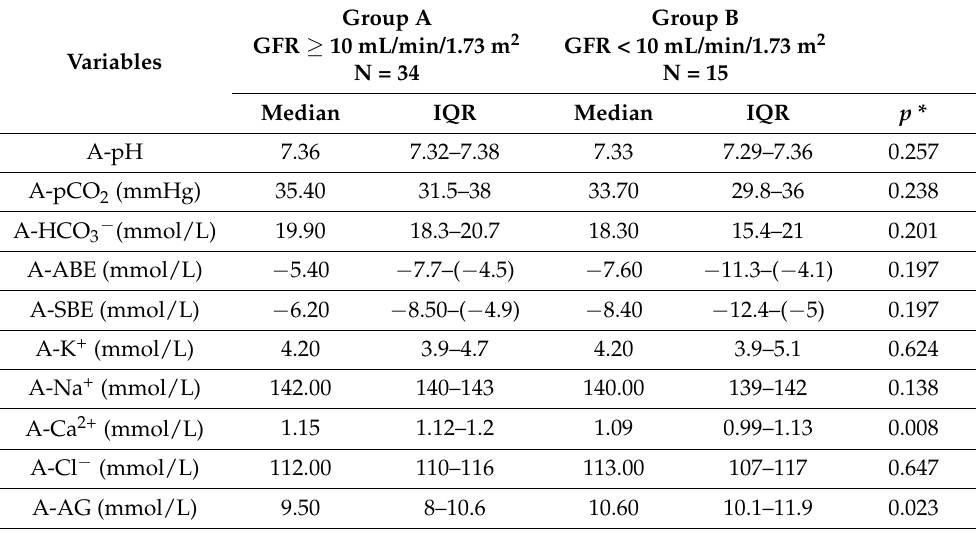
Table 2. Comparison between POCT and kidney function parameters in Group A and